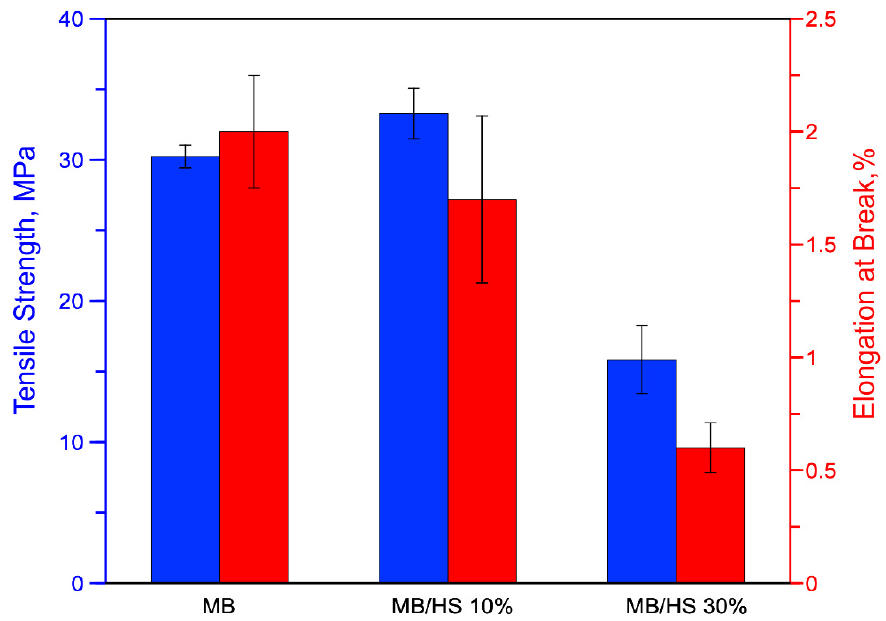
Figure 9. Histogram of tensile strength and elongation at break of MB and biocomposite. This decrease in tensile strength of the MB/HS 30% sample may be associated with premature failure of the samples; see Figure 10.